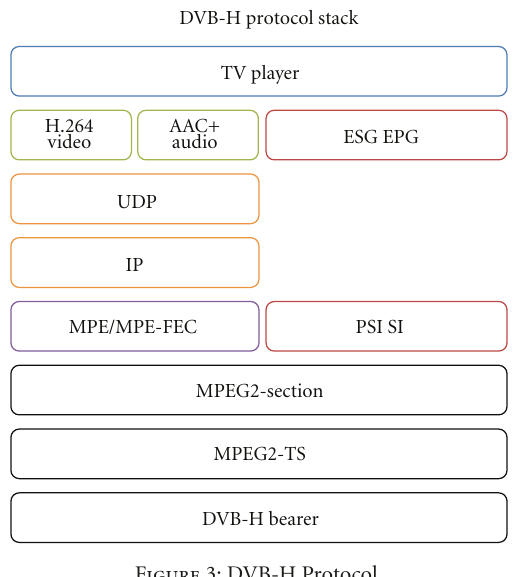
Figure 3: DVB-H Protocol.